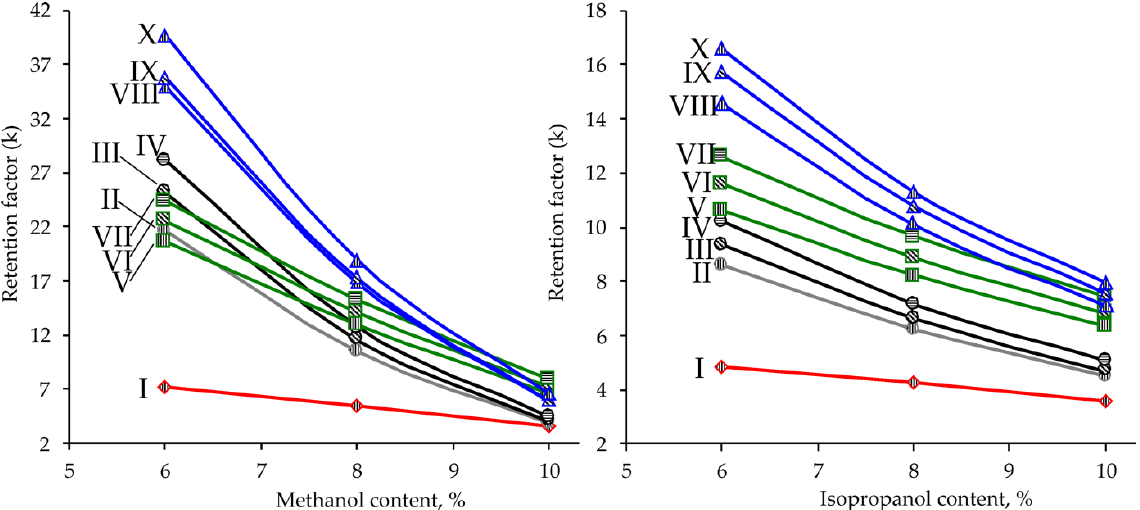
Figure 2. Effect of methanol ( left ) and isopropanol ( right ) content in the mobile phase on the retention factors of PCTs on HSS C18 SB stationary phase (flow rate 1.5 mL ∙ min –1 , T = 25 °C, backpressure 150 bar).